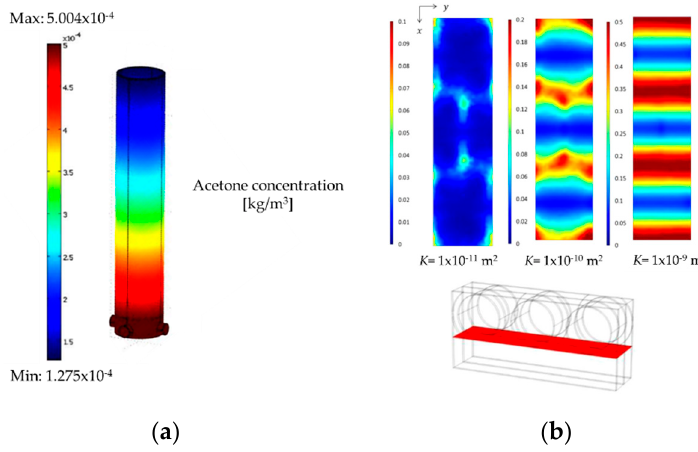
Figure 17. ( a ) Variation of acetone inside the annular reactor, C 0 = 5 × 10 − 4 kg/m 3 ; (adapted from Reference [35], Copyright (2011), with permission from Elsevier) and ( b ) U S / U Max ratio between interface slip velocity and the maximum velocity for various permeabilities ( K ); (reprinted from Reference [139], Copyright (2015), with permission from Elsevier).